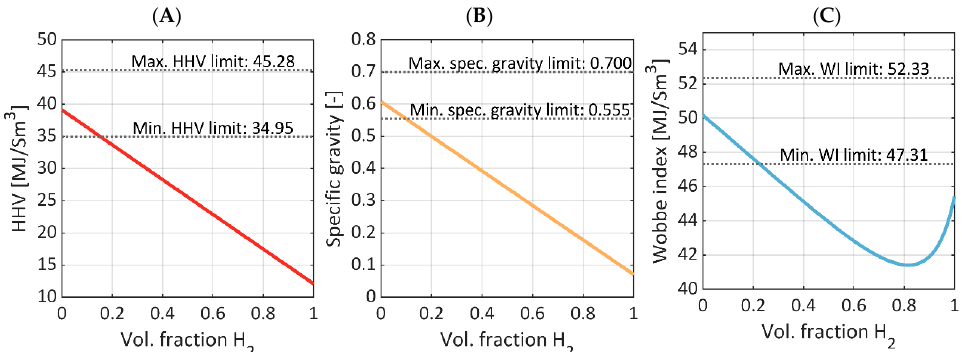
Figure 3. Variation in thermophysical properties of H 2 –NG blends with volume concentrations of H 2 : ( A ) HHV, ( B ) specific gravity, ( C ) Wobbe index, with given natural gas composition.